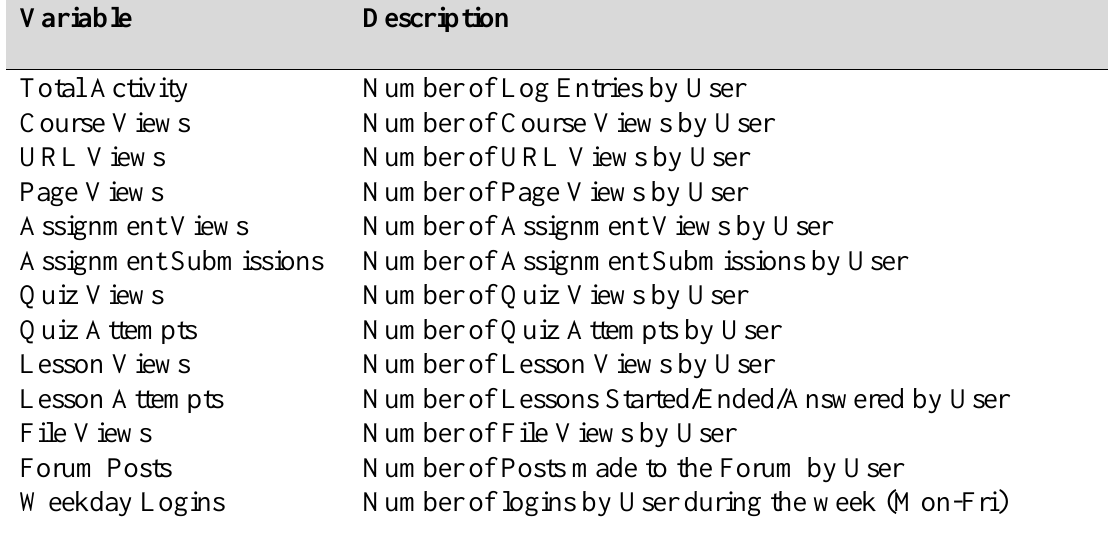
Table 1: Predictor Variables Used in the Study